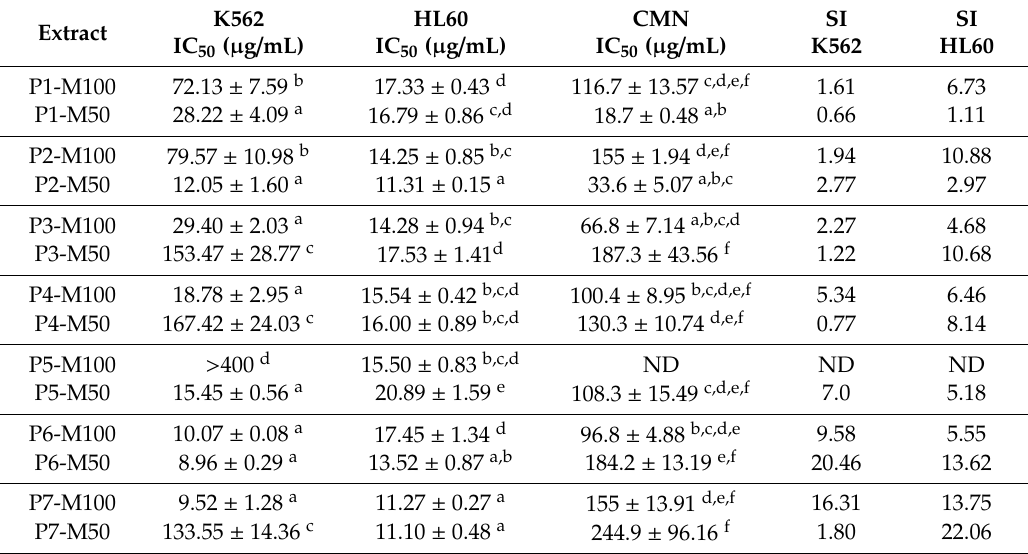
Table 3. Anti-proliferative activity of 50 and 100% methanol extracts of Asclepias linaria leaves against hematologic neoplasia cells lines (K562 and HL60) and normal mononuclear cells